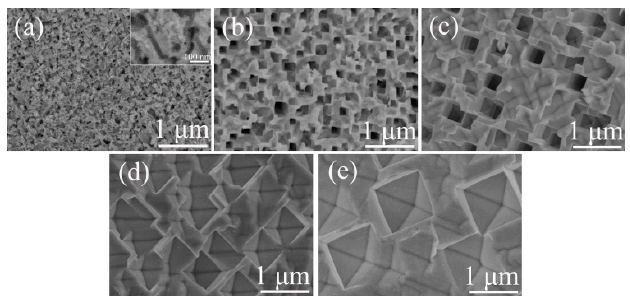
Figure 3. SEM images of the etched samples ( a ) after 180 s Cu/Ag co-assisted etching and a post NSR treatment 360 s at ( b ) 30 °C; ( c ) 40 °C; ( d ) 50 °C; ( e ) 60 °C.